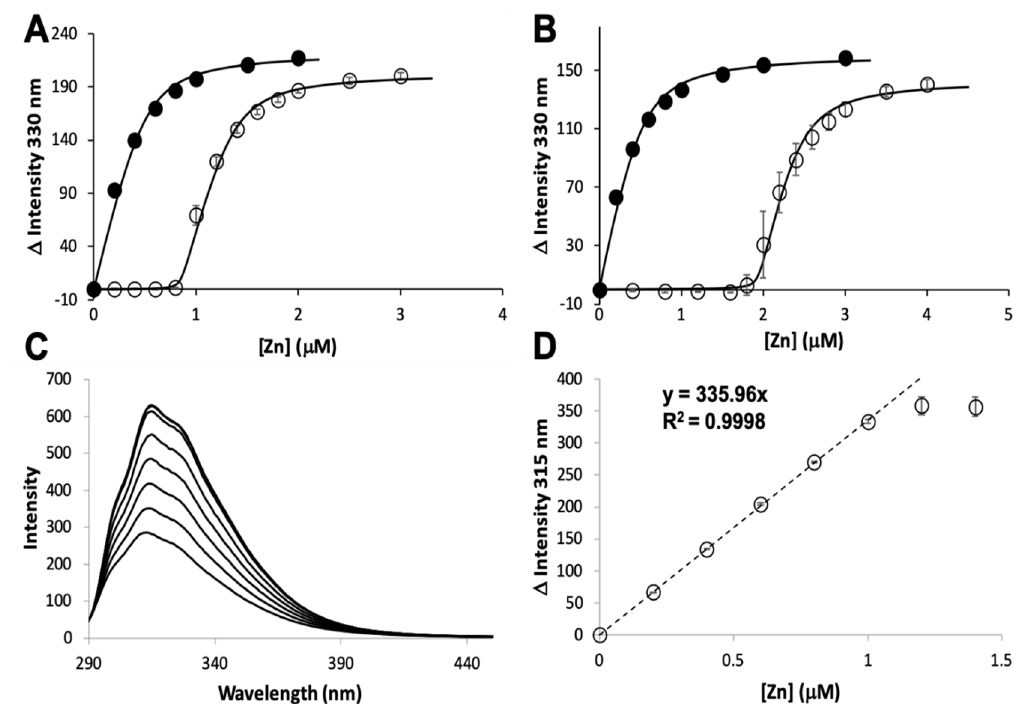
Figure 2. Zinc binding by AztC and AztD mutants. Intensity change of MF2 at 330 nm with increasing zinc in the absence (solid circles) and presence (empty circles) of apo H138/204A AztC ( A ) and ∆ N-terminal motif (NTM) AztD ( B ). ( C ) Fluorescence emission spectra of H138 / 204A AztC ( λ exc = 278 nm) and ( D ) magnitude of the fluorescence intensity change with increasing zinc concentration. Titrations containing protein were performed in triplicate and error bars represent the standard deviation between measurements. Least squared fits are shown as solid lines for ( A ) and ( B ) and a dotted line for the linear fit in ( D ) with slope and R 2 values